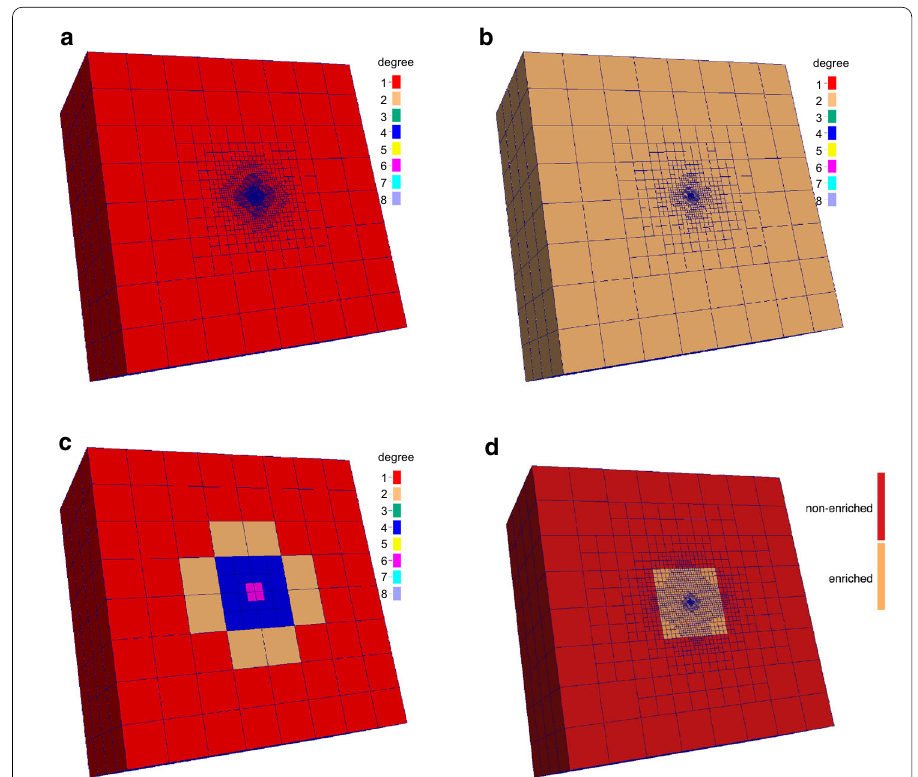
Fig. 3 Cross-sections of the final adaptive meshes for the Coulomb potential when solving for a single eigenpair. a h -adaptive FEM (linear). b h -adaptive FEM (quadratic). c hp -adaptive FEM. d h -adaptive PUM